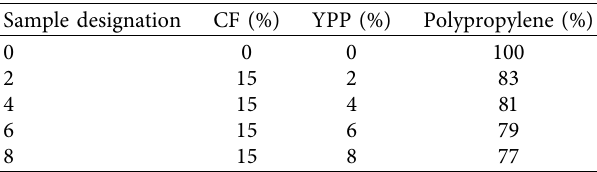
Figure 1: Images of (a) coir fibre, (b) YPP, and (c) test samples. Table 1: Proportion of materials employed in composite